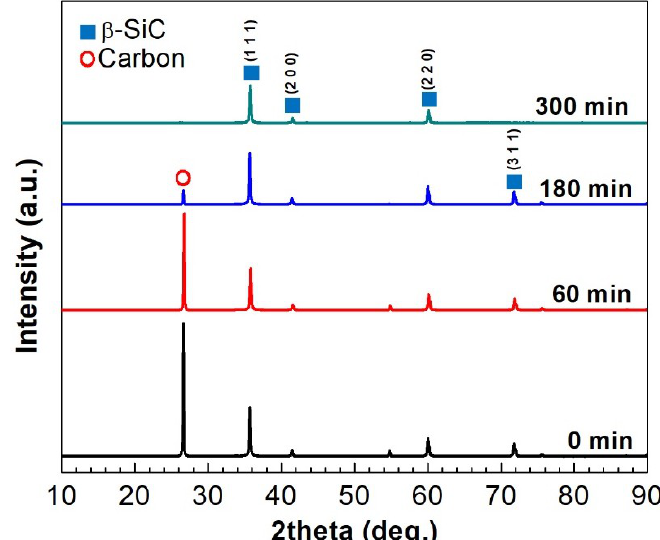
Figure 9. XRD patterns of the SiC powder product at different carbon removal treatment times (T = 750 °C).